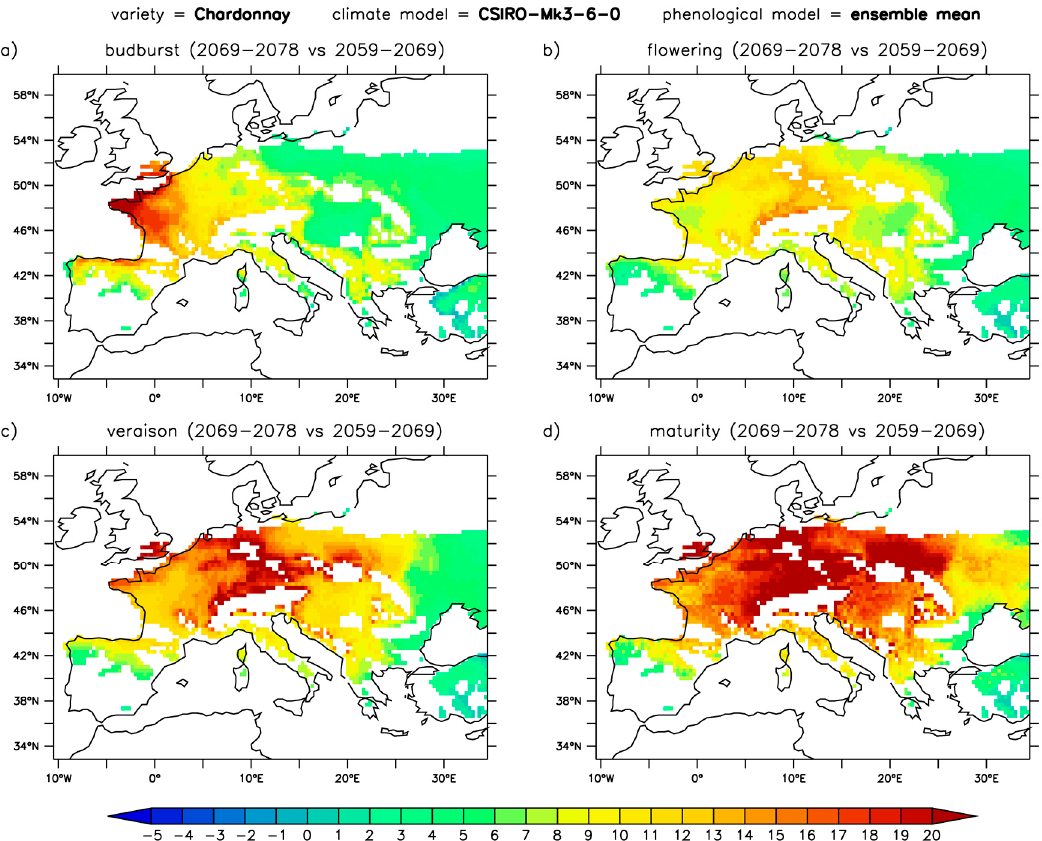
Figure 4. Pattern of the anomaly (in days) of the occurrence of the phenological stages, i.e., ( a ) budburst, ( b ) flowering, ( c ) veraison, and ( d ) maturity, for the Chardonnay variety between the decade 2069–2078 and the decade 2059–2068 as simulated by the downscaled CSIRO-Mk3-6-0 model. Results are based on the ensemble mean of the three phenological models here adopted.